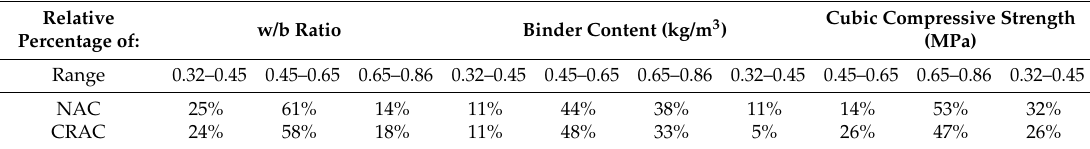
Table 2. w/b ratios, binder contents, and cubic compressive strength of the mixes.